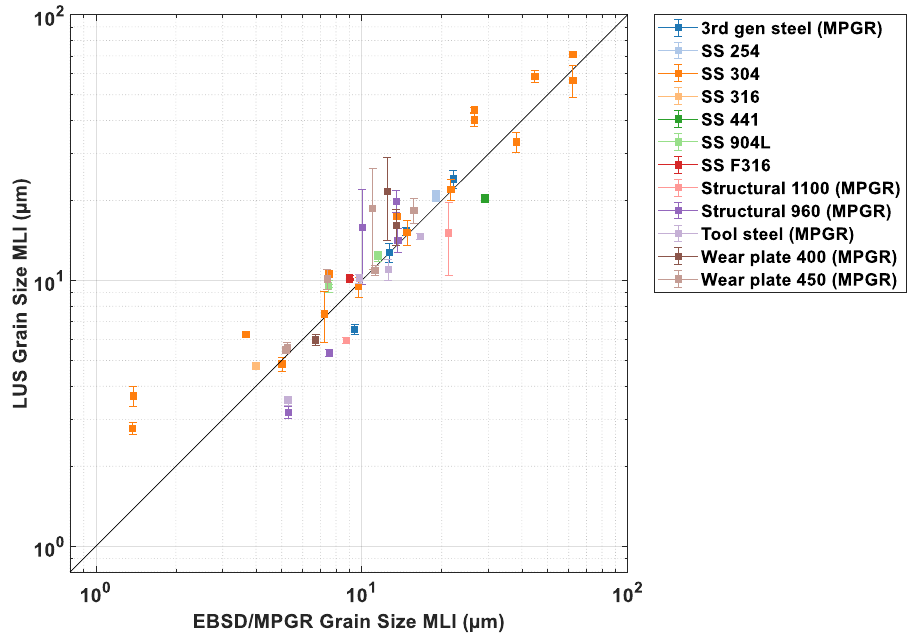
Figure 5. Calculated LUS grain size versus the mean linear intercept-length grain size, as measured by EBSD and MPGR, including the twin boundaries. The error bars in the vertical direction represent the standard deviation of all of the LUS shots considered when calculating the average grain size.